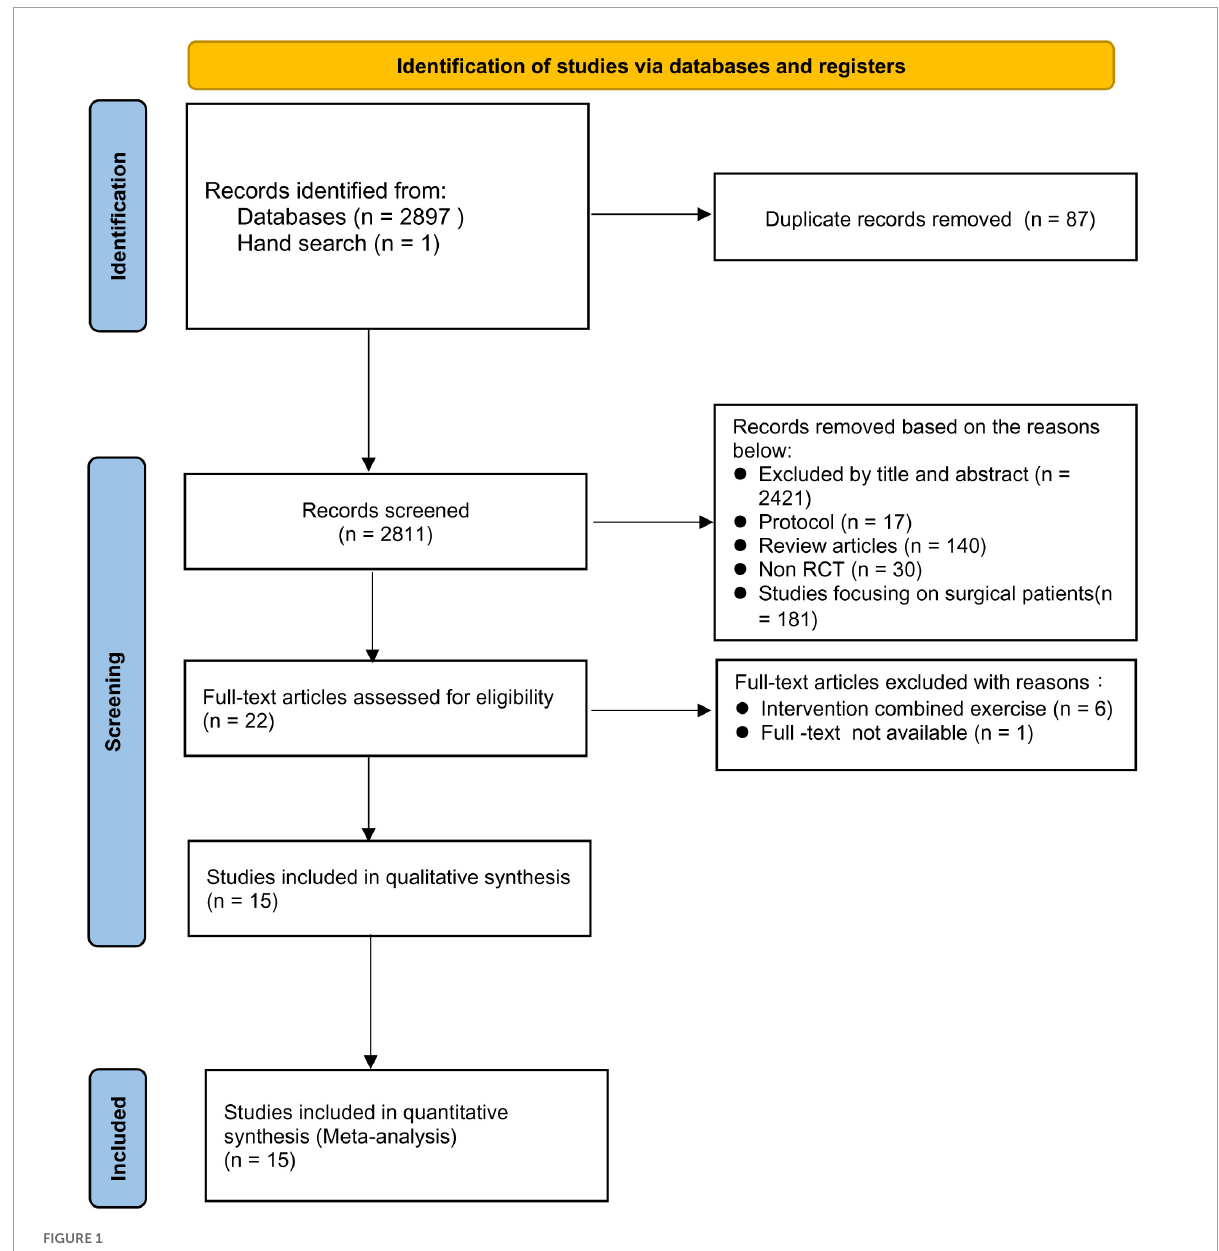
FIGURE1 Screening process for study